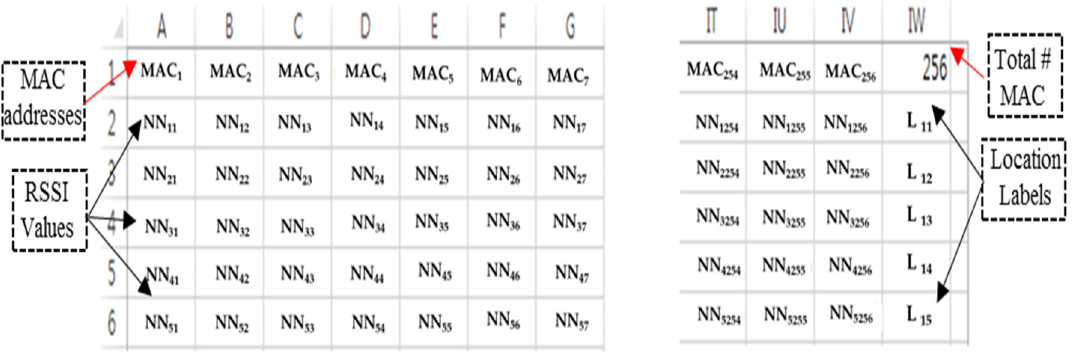
Figure 3. Comma-separated values (CSV) file format used as the input file Figure 3. Comma ‐ separated values (CSV) file format used as the input file [6].